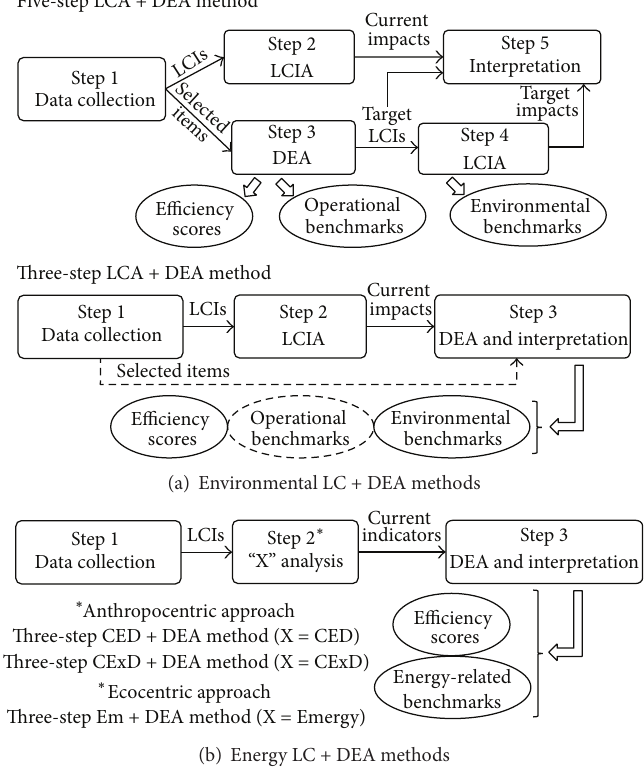
Figure 1: LC + DEA methods currently available (CED: cumulative energy demand; CExD: cumulative exergy demand; DEA: data envelopment analysis; Em: emergy; LCA: life cycle assessment; LCI: life cycle inventory; LCIA: life cycle impact